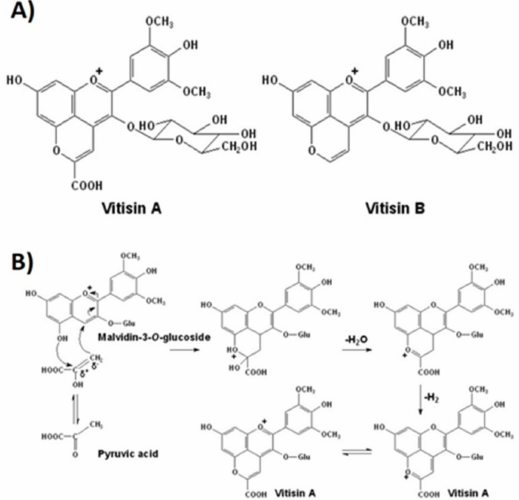
Figure 3. ( A ) Structures of vitisin A and vitisin B generated from malvidin-3- O -glucoside. ( B ) The formationmechanismofvitisinAproducedbycondensationofananthocyanin(malvidin-3- O -glucoside) with pyruvic acid